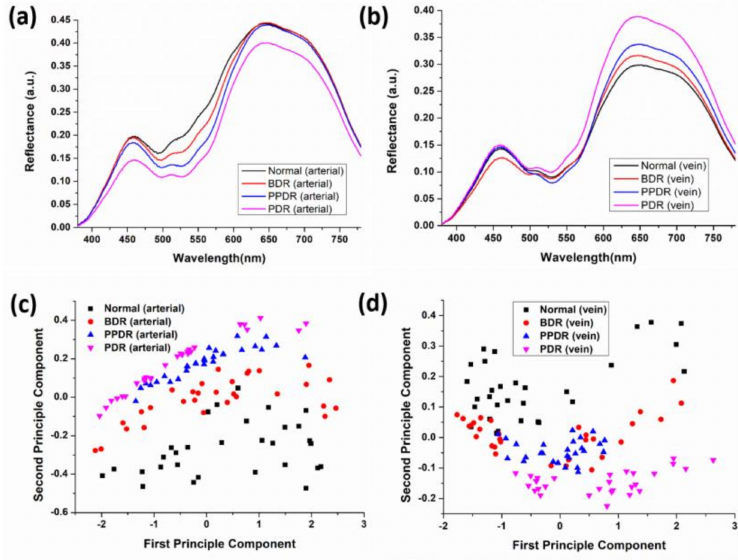
Figure 6. Average reflection spectrum of Normal, BDR, PPDR, and PDR retinas of ( a ) arterial and ( b ) vein; principal component scores of spectral features of ( c ) arterial and ( d )